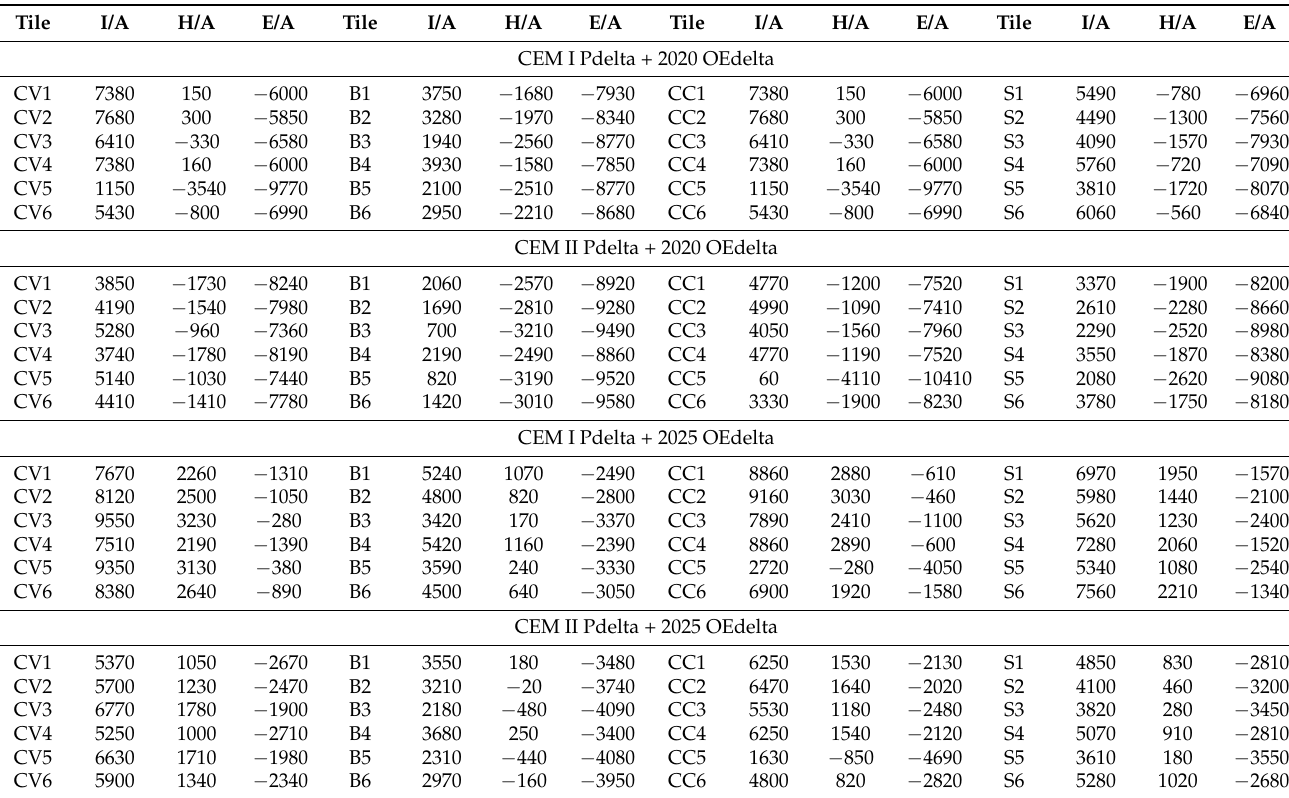
Table 8. Groups CV, B, CC, and S sculptured tiles. Total P + OE stage: environmental damage/benefit of Pdelta + OEdelta. Evaluation was performed with ReCiPe2016 endpoint single-score method using individualist/average (I/A), hierarchist/average (H/A), and egalitarian/average (E/A)